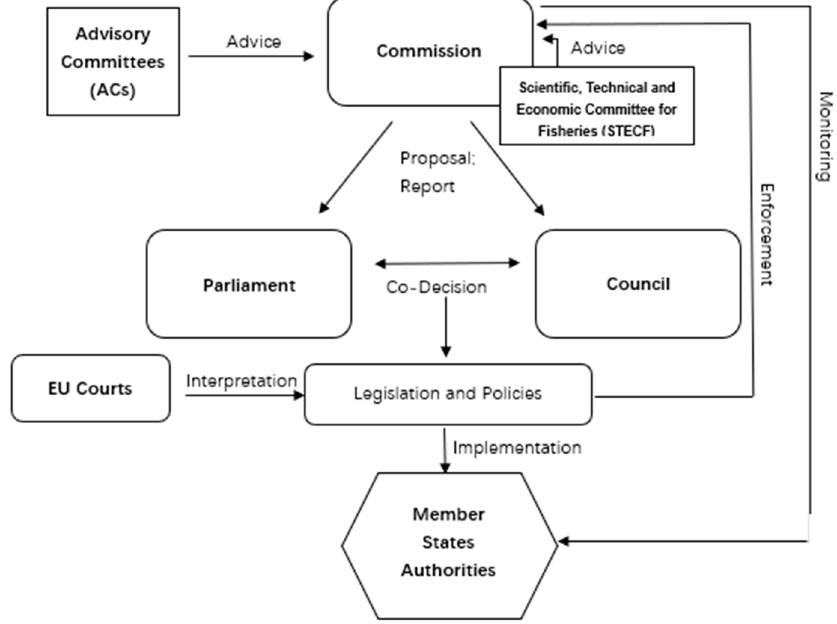
Figure 1. EU Fisheries Management Scheme. Source: Regulation (EU) No. 1380/2013, Luchman (2008) [71].